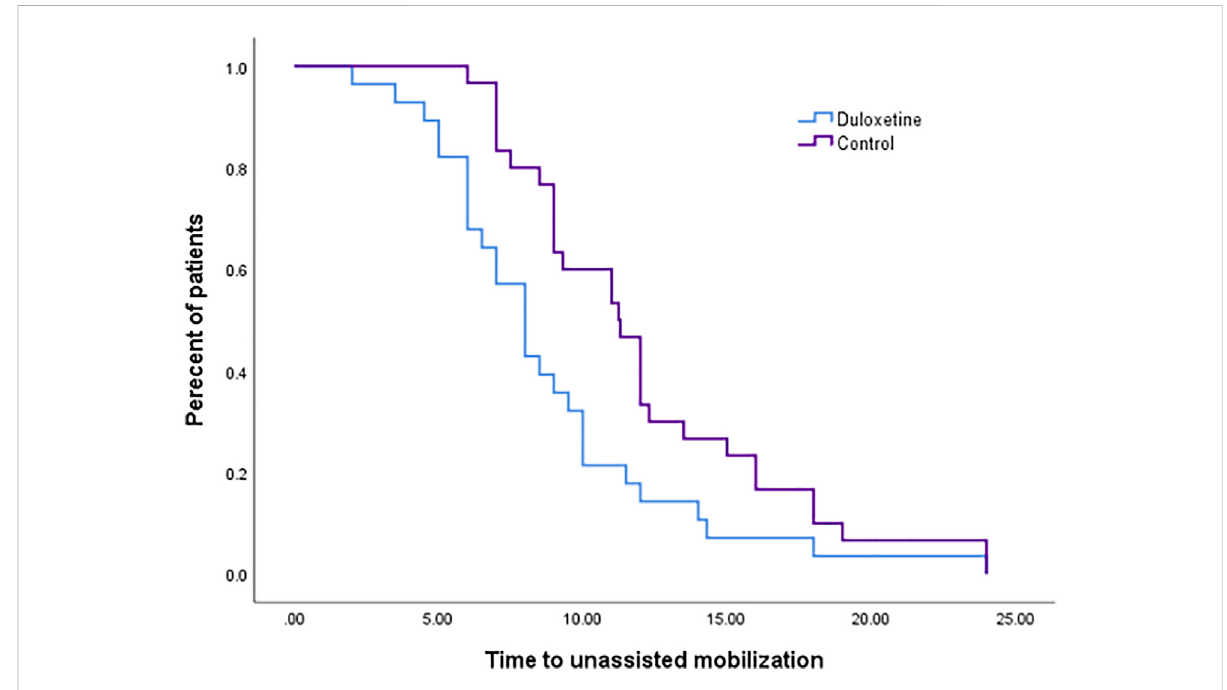
FIGURE 3 Kaplan-Meier survival curve represents time to unassisted mobilization ( p = 0.014).